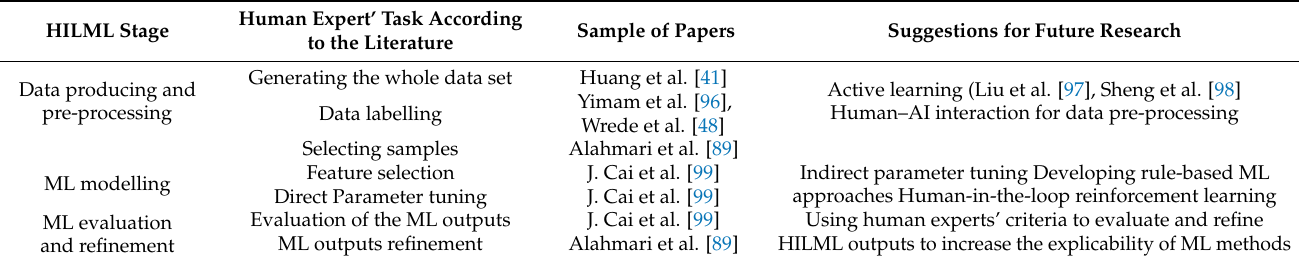
Table 2. Human–AI interaction in medical ML